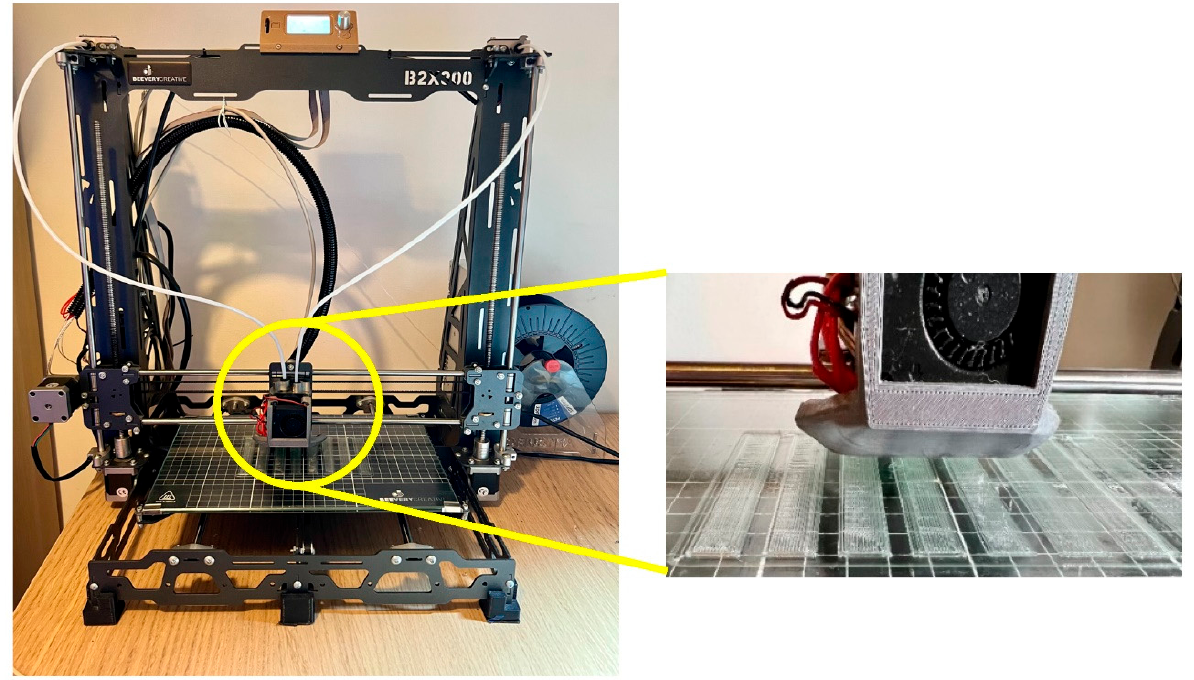
Figure 1. Details of the 3D printer used to produce specimens in a temperature and humidity-controlled room.